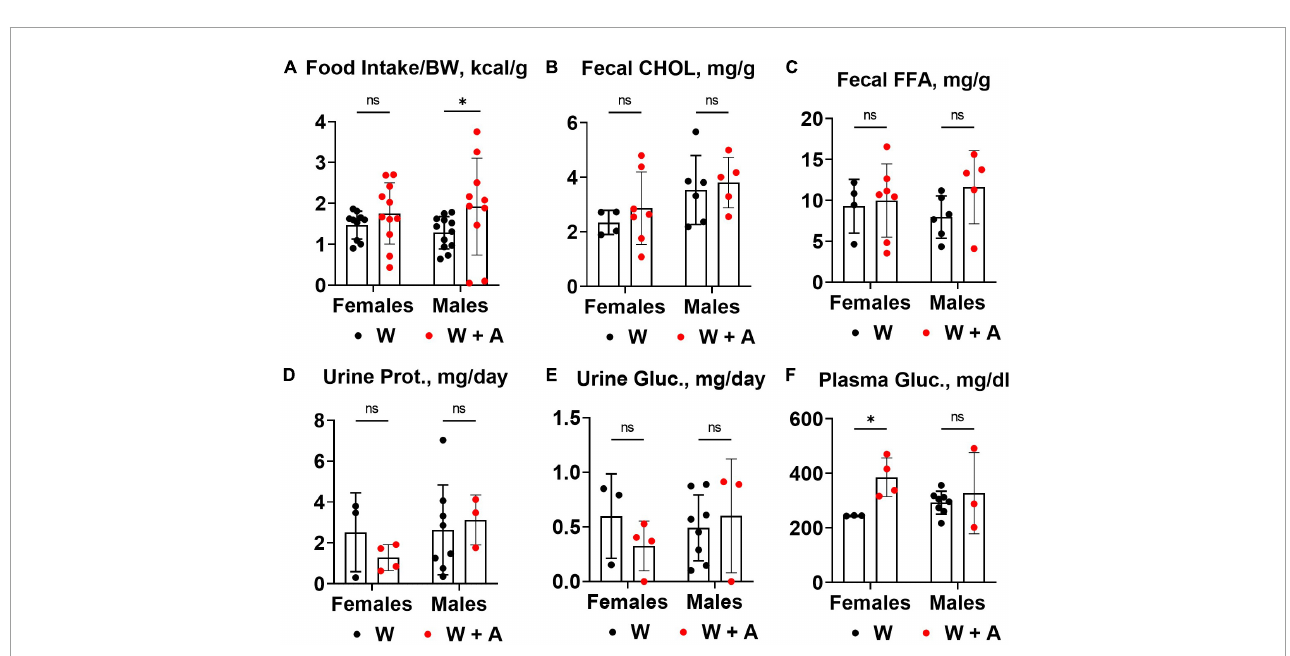
FIGURE3 Food consumption and macronutrient excretion in feces and urine of WHC mice co-treated with adenine and a western diet. (A) Caloric intake per body weight (BW). (B) Fecal cholesterol (CHOL) content. (C) Fecal free fatty acids (FFA) content. (D) 24-h urine protein excretion. (E) 24-h urine glucose excretion. (F) Plasma glucose concentration. n = 3–11 per group; two-way ANOVA; ns, not significant; ∗ p <